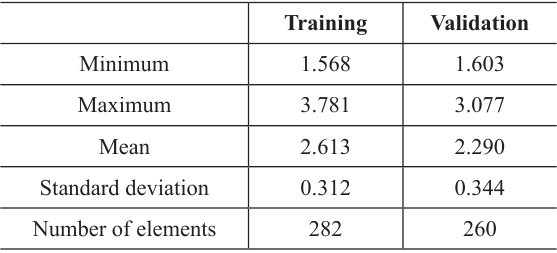
Descriptive statistics of the training and validation sets.